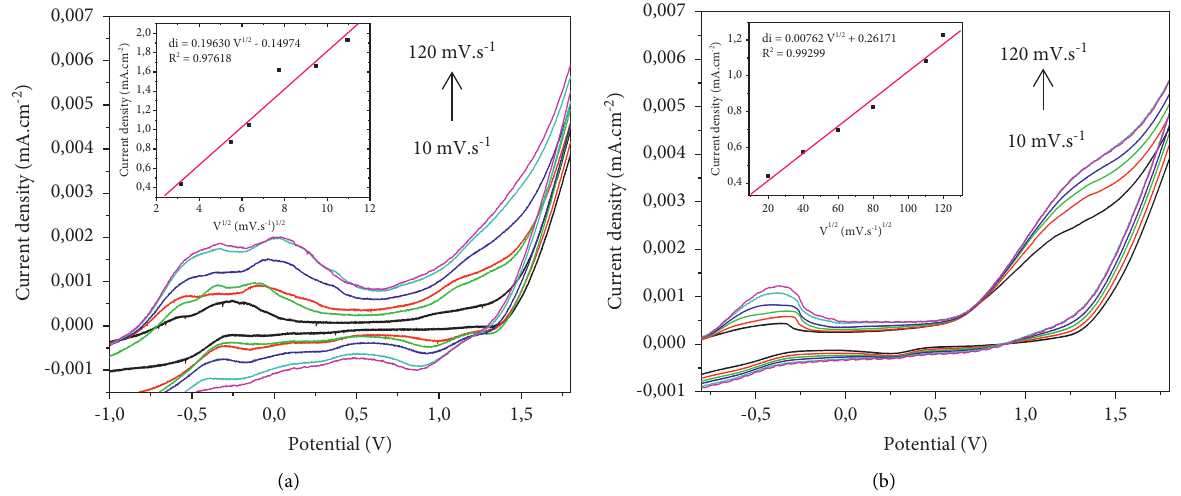
Figure 6: Scan rate effect (Hg/Hg